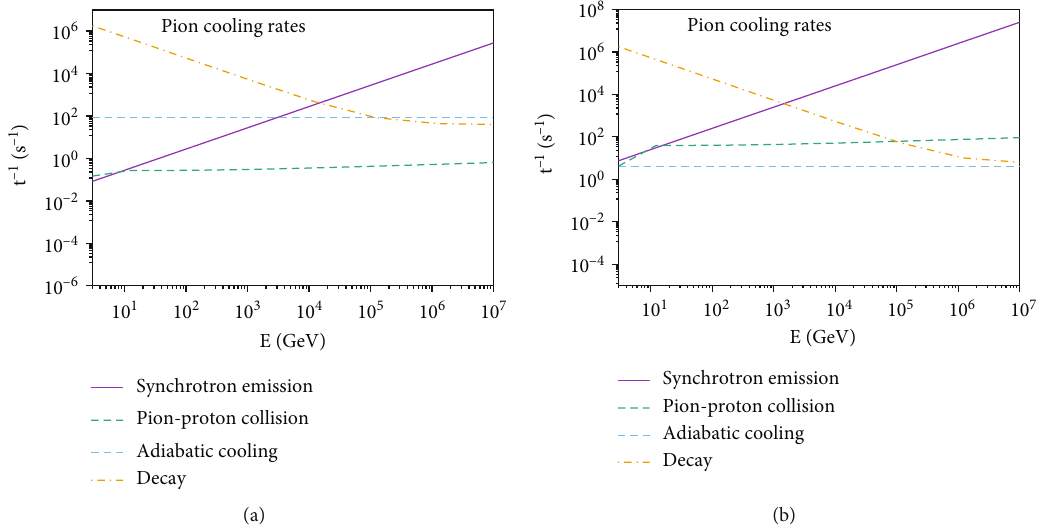
Figure 1: Cooling rates for protons in the jets of M33 X-7 (a) and SS 433 (b) at the base of the jets z synchrotron emission (solid lines), the adiabatic cooling (dotted lines), and the inelastic p-p collision rate (dashed lines).